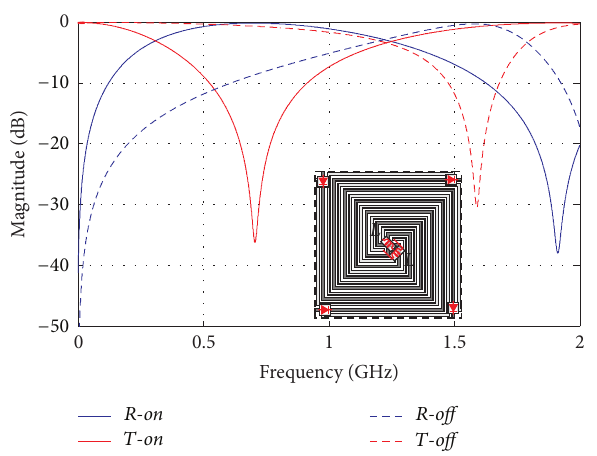
Figure 13: Transmittance and reflectance of the AFSS with the unit cell of Figure 8 at normal incidence when switches, with low off capacitance 𝐶 𝑡 = 0.056 pF, are in the on (solid lines) and off (dashed lines)